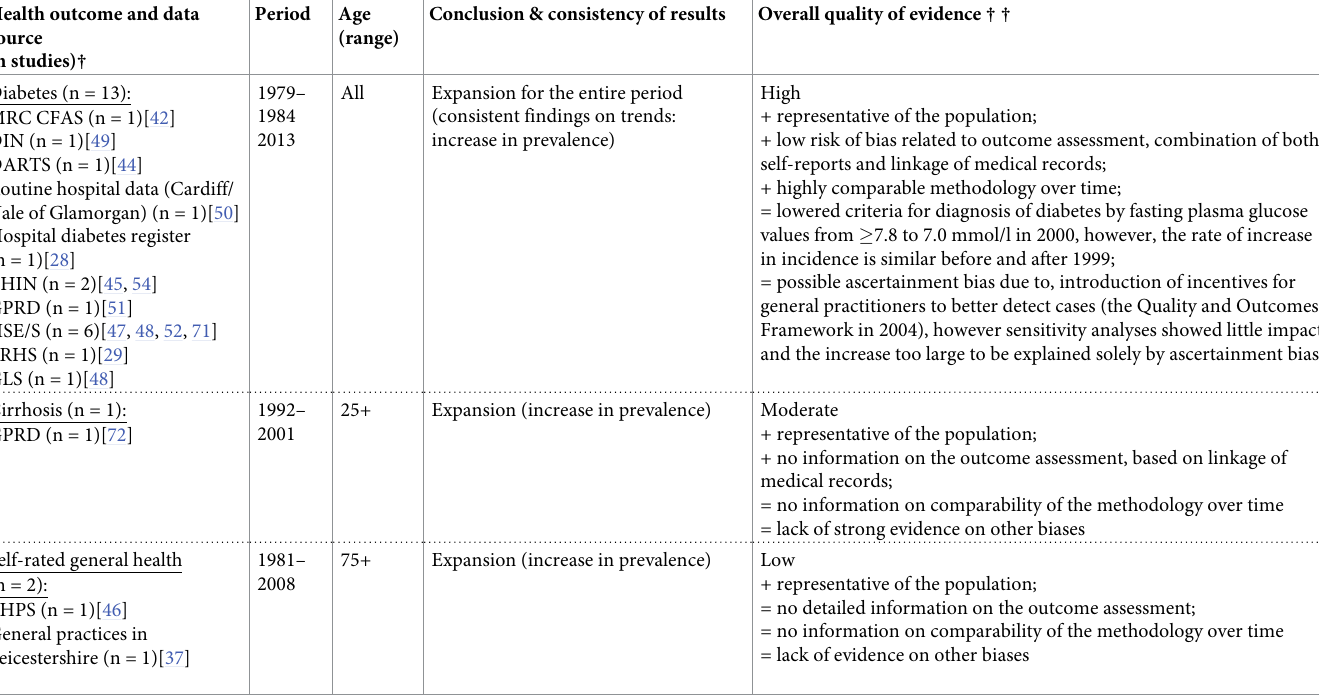
Table 6. The characteristics of evidence on prevalence of each health outcome, with the emphasis on size, consistency and quality (cont.).